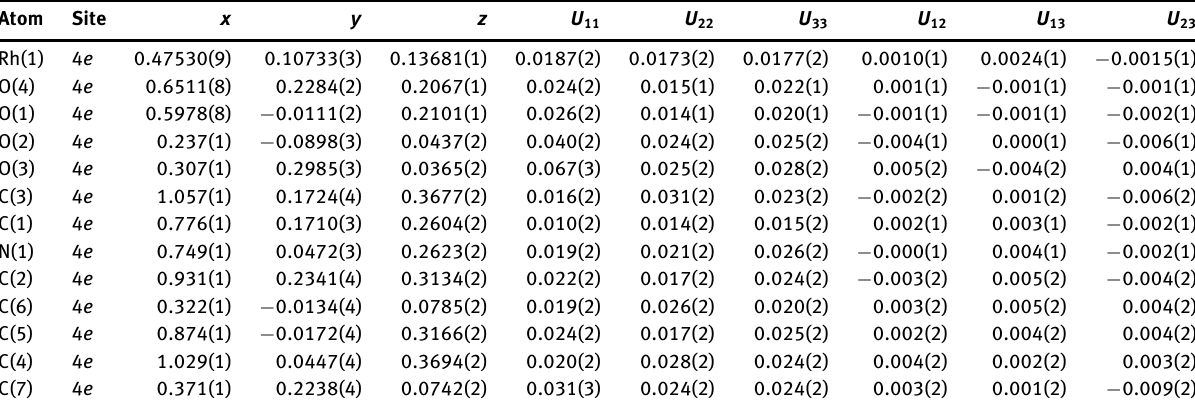
Table 3: Fractional coordinates and atomic displacement parameters (Å 2